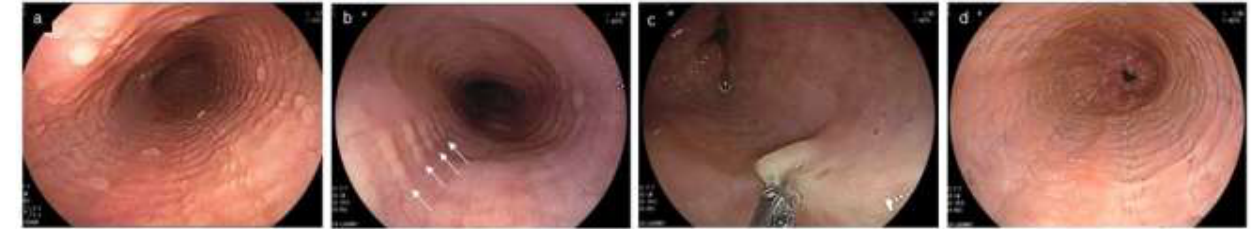
Figure 7. Other endoscopic findings related to EoE. ( a ). Multiple polypoid lesions ( b ). Ankylosaurus back sign ( c ). Tug sign/pull sign: with pulling by the biopsy forceps, a large amount of esophageal mucosa is lifted as a tent and caught in the forceps opening. ( d ). Caterpillar sign. EoE, eosinophilic esophagitis.